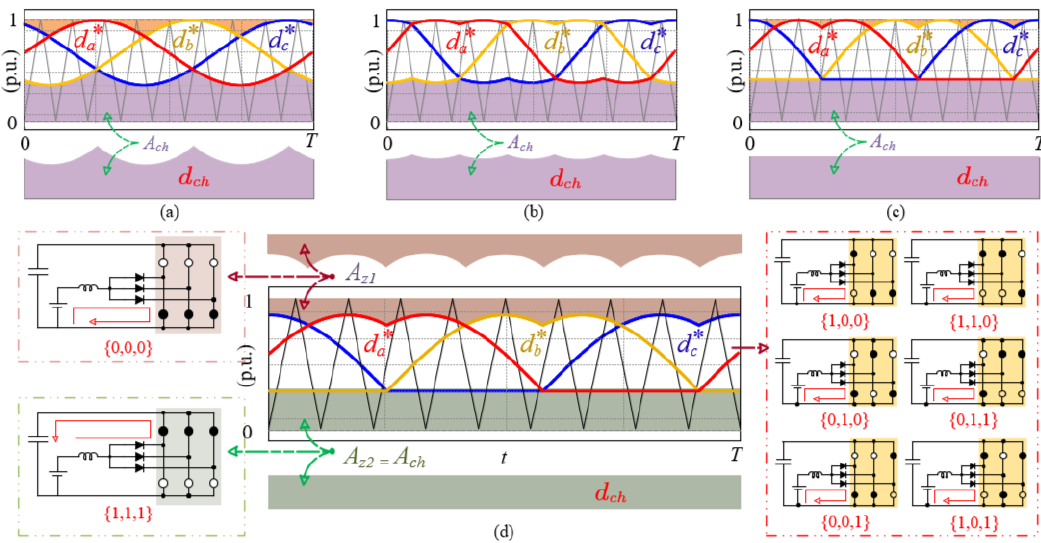
Figure 6. Modulation of three-phase split-source inverter based on level-shifted approach. ( a ) SM, ( b ) SYM, ( c ) MSVM, ( d ) and RSVM scheme. The superscript * denotes the reference waveform.